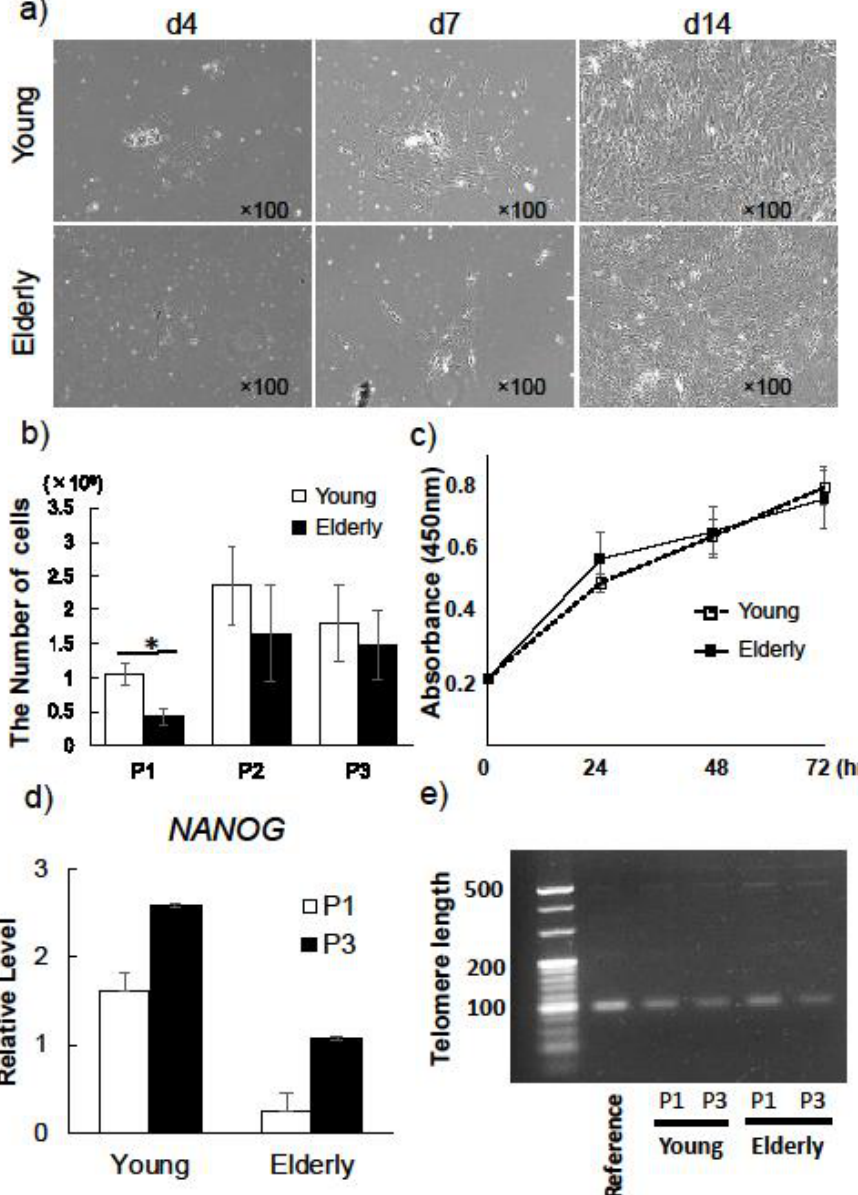
Figure 1. Characterization of dental pulp stem cells (DPSCs) derived from young and elderly patients. ( a ) Cell morphology of DPSCs derived from young and elderly patients at initial culture. Gross view at day 4, day 7, and day 14. ( b ) Comparison of proliferation potential of DPSCs derived from young and elderly patients in passage 1 (P1) to P3. The number of collected cells was counted at each passage ( n = 4) (* p < 0.05). ( c ) Proliferation ability of young and elderly DPSCs at P2 were analyzed at 24, 48, and 72 h of culture. ( n = 4) (* p < 0.05). ( d ) Comparison of expression of stem cell marker (NANOG) in the DPSCs derived from young and elderly patients at P1 and P3 ( n = 4) (* p < 0.05). ( e ) Comparison of telomere length in the DPSCs derived from young and elderly patients at P1 and P3. The reference genomic DNA sample with known telomere length is shown on the left ( n = 3). The experiments were repeated three times, and one representative image is